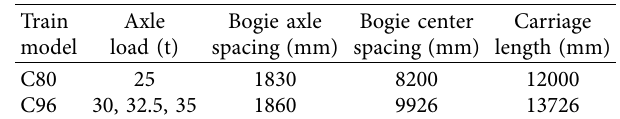
Figure 2: Train vehicle model: (a) carriage components; (b) perspective view of the train model. Table 1: Main parameters of simulated trains.